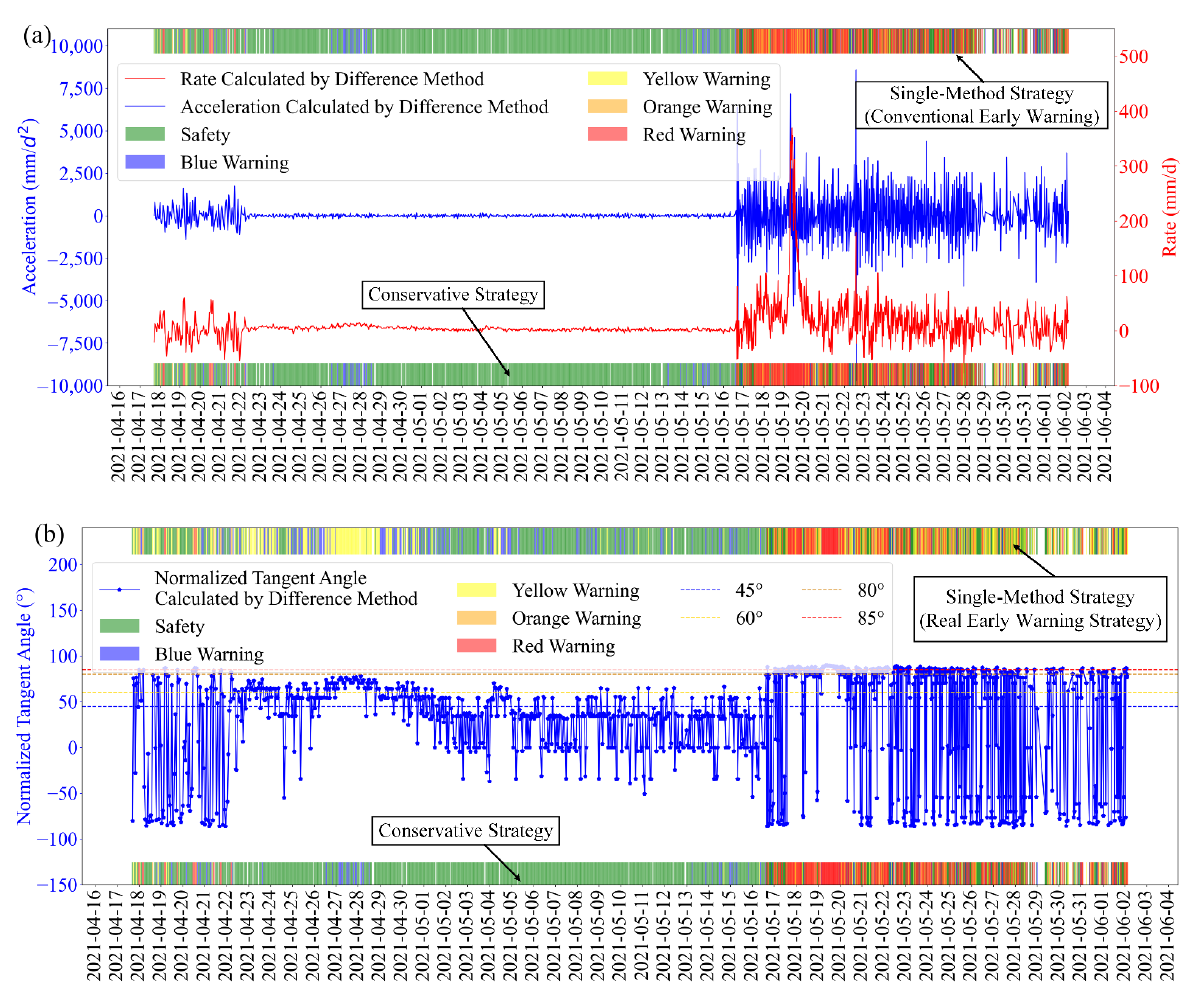
Figure 10. Early warning results of the LISHAN-DB02 monitoring station obtained by the traditional difference method. ( a ) Conventional warning based on velocity and acceleration ( b ) critical sliding warning based on the normalized tangent angle.